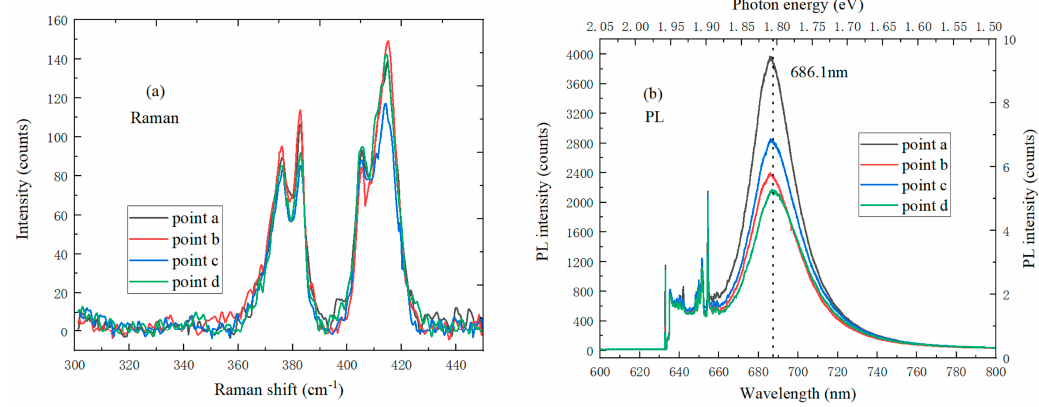
Figure 8. Optical properties of monolayer MoS 2 on a SiO 2 /Si substrate under the laser wavelength of 633 nm ( a ) Raman spectrum; ( b ) PL